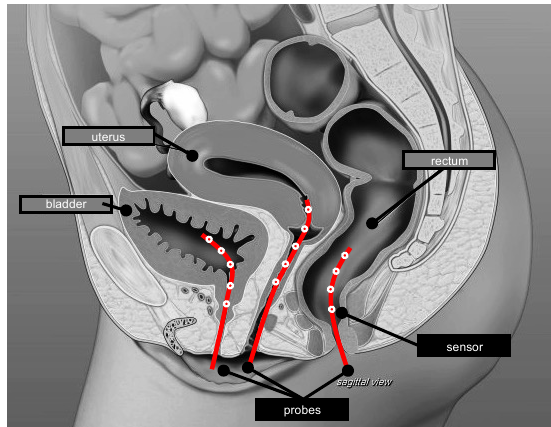
Figure 2. Schematic illustration of the difference between temperature probes and sensors for the pelvic region. The number of probes is three and the number of sensors 14. The number of sensors per probe ranges between four and five.